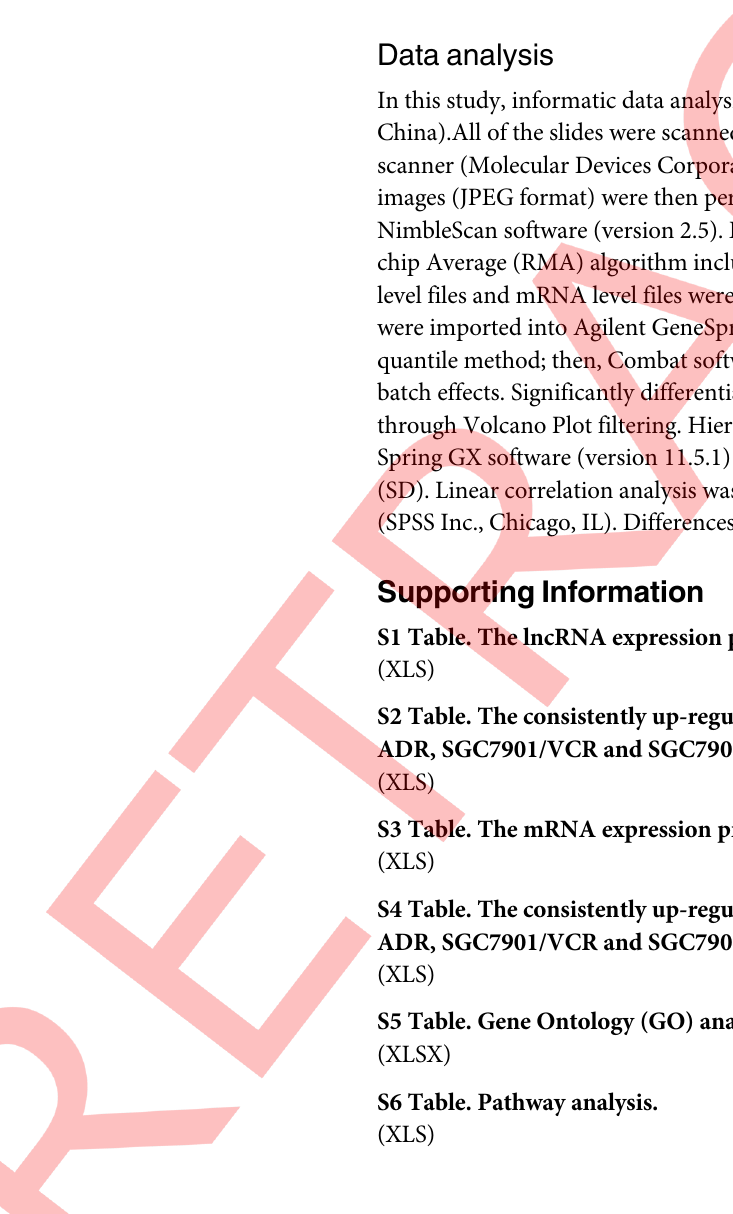
S4 Table. The consistently up-regulated and down-regulated mRNAs between SGC7901/